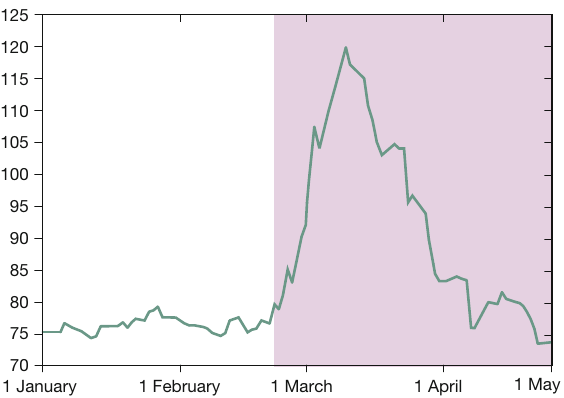
Daily rouble exchange rate (per US dollar) in